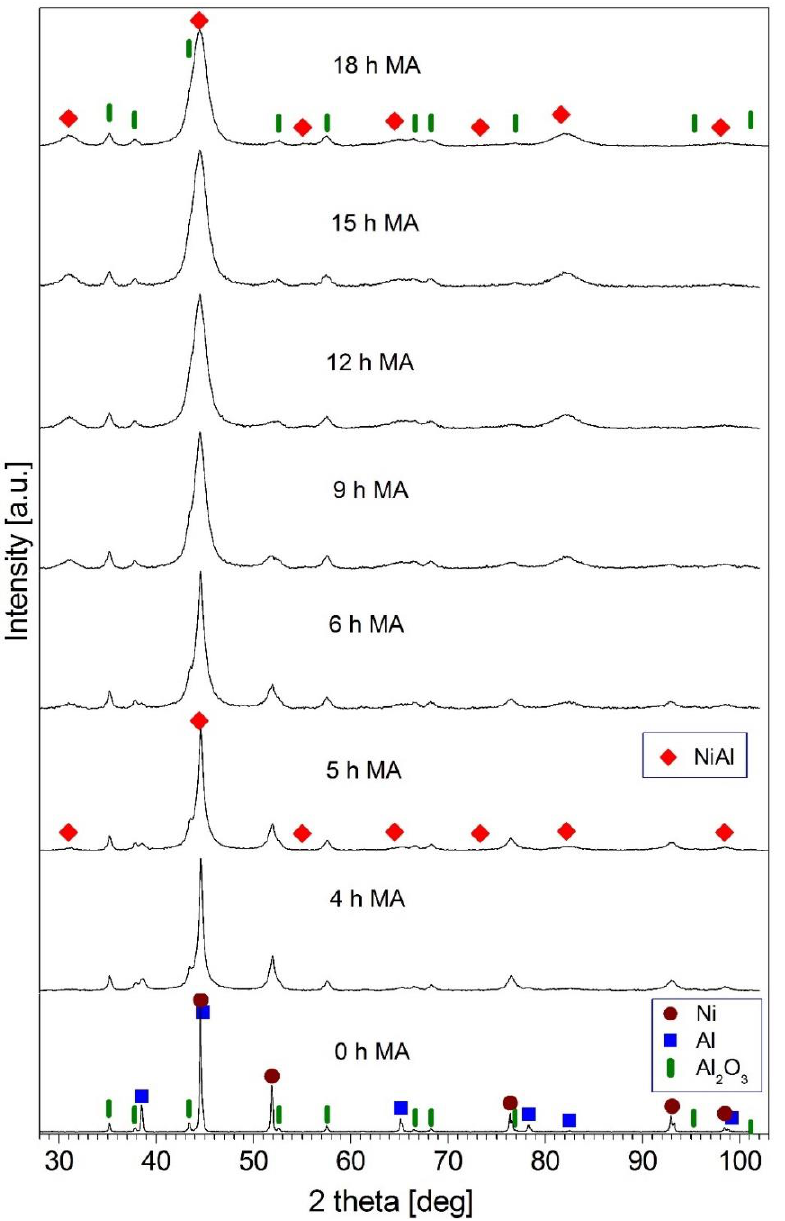
Figure 5. XRD patterns of the (Ni-50 at.% Al) + 30 wt.% Al 2 O 3 powder blend mechanically alloyed for the times quoted.